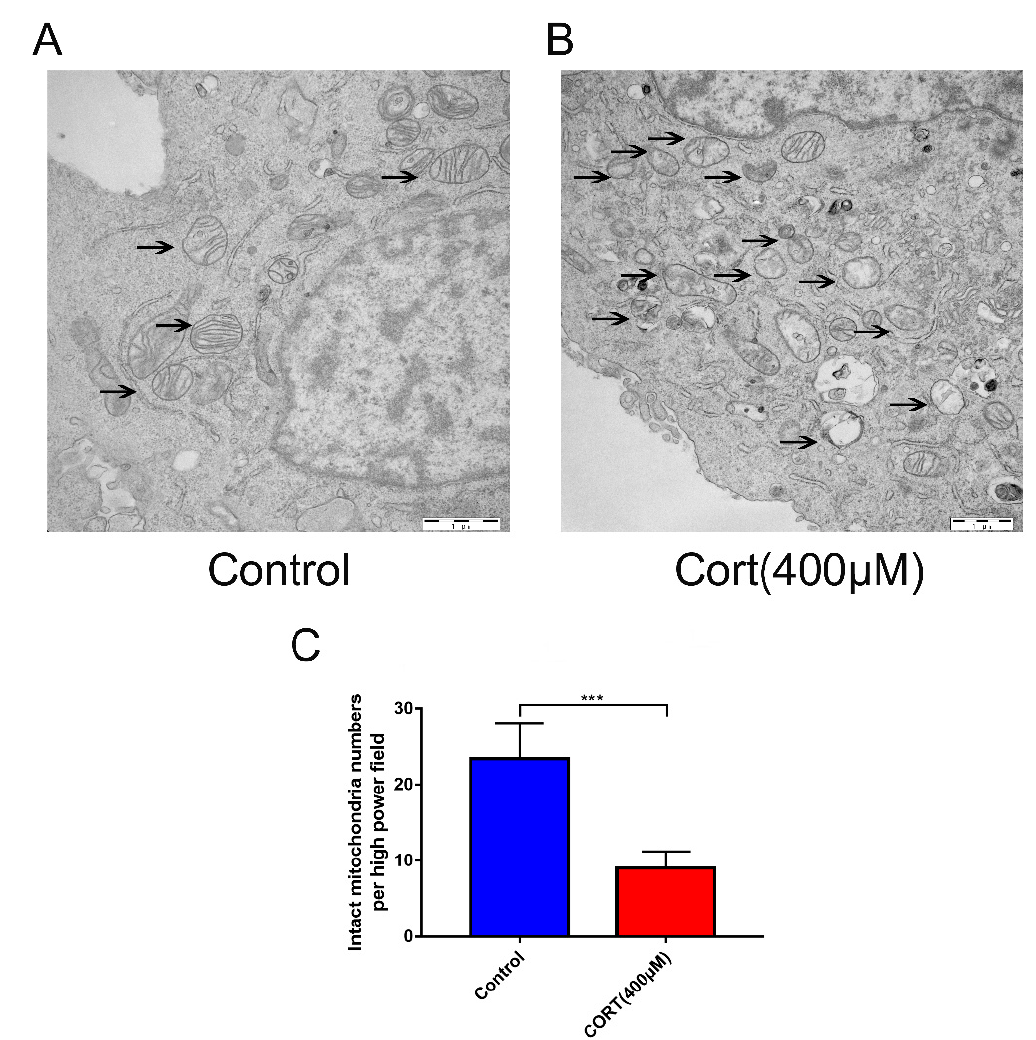
Figure 9. HT22 cells were observed by electron microscopy after cortisol (CORT) treatment for 3 h ( A , B ), whether the mitochondria intact (with intact mitochondrial cristae and membrane) or not was indicated by arrows, and the numbers of intact mitochondria were counted ( C ). Data were compared between control (CORT 0 µ M) vs. CORT (400 µ M), and were analyzed by one-way analysis of variance. The results are expressed as the mean ± SD ( n = 3) in each independent experiment; *** p < 0.001.